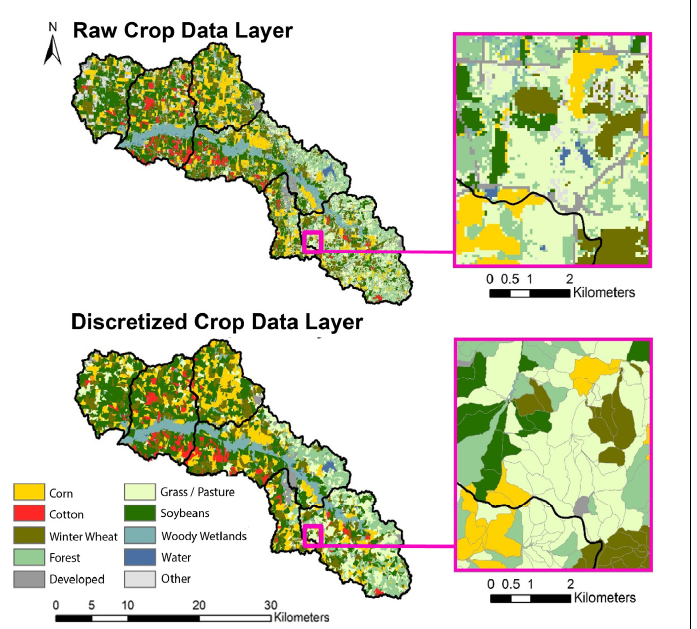
Figure 4. Spatial-temporal characterization of land use. The procedure was applied for all years, but only 2008 is included for illustration purposes. The input AnnAGNPS farming management database was assembled by integrating three sources of information: (1) spatiotemporal crop type information at sub-watershed scale (from annual discretized CDL datasets), (2) average annual crop type yield infor- mation at county scale (from agricultural census downloaded from USDA-NASS [60]), and (3) one-year farming practices (from RUSLE 2 database). The latter represent typical farming operations and schedules for a particular crop type in this region (Table 2). The three datasets were combined using a custom Python script, generating 4135 unique 11- year crop/landuse rotations for the 12,573 sub-catchments in the study area. The output from the custom script are management schedule and operation databases required by the AnnAGNPS model.